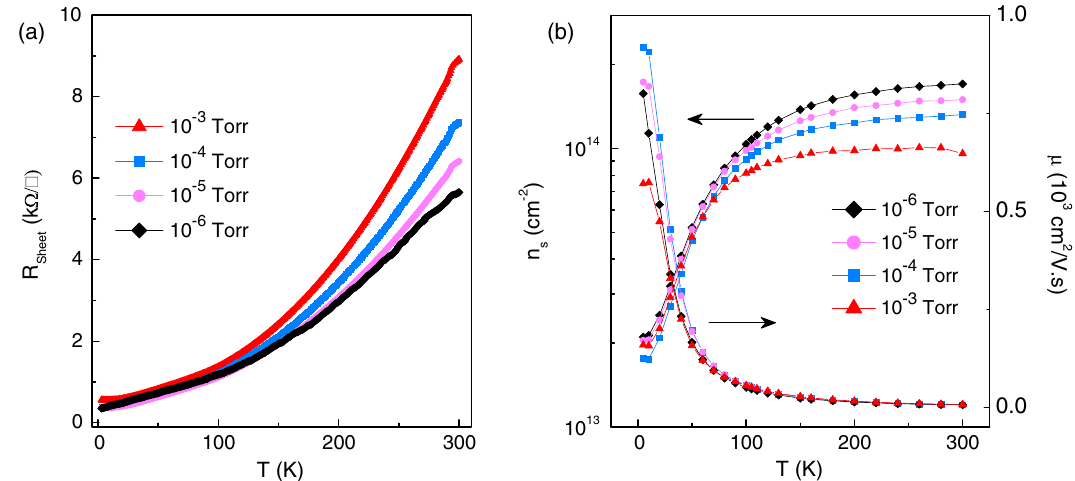
FIG. 2. Electrical transport properties of amorphous LAO/STO heterostructures. (a) The temperature dependence of sheet resistance ( R s - T ) and (b) sheet carrier density ( n s - T ) and the corresponding mobility for 20-nm amorphous LAO/STO heterostructures fabricated at different oxygen pressures from 10 (cid:2) 3 Torr to 10 (cid:2) 6 Torr .